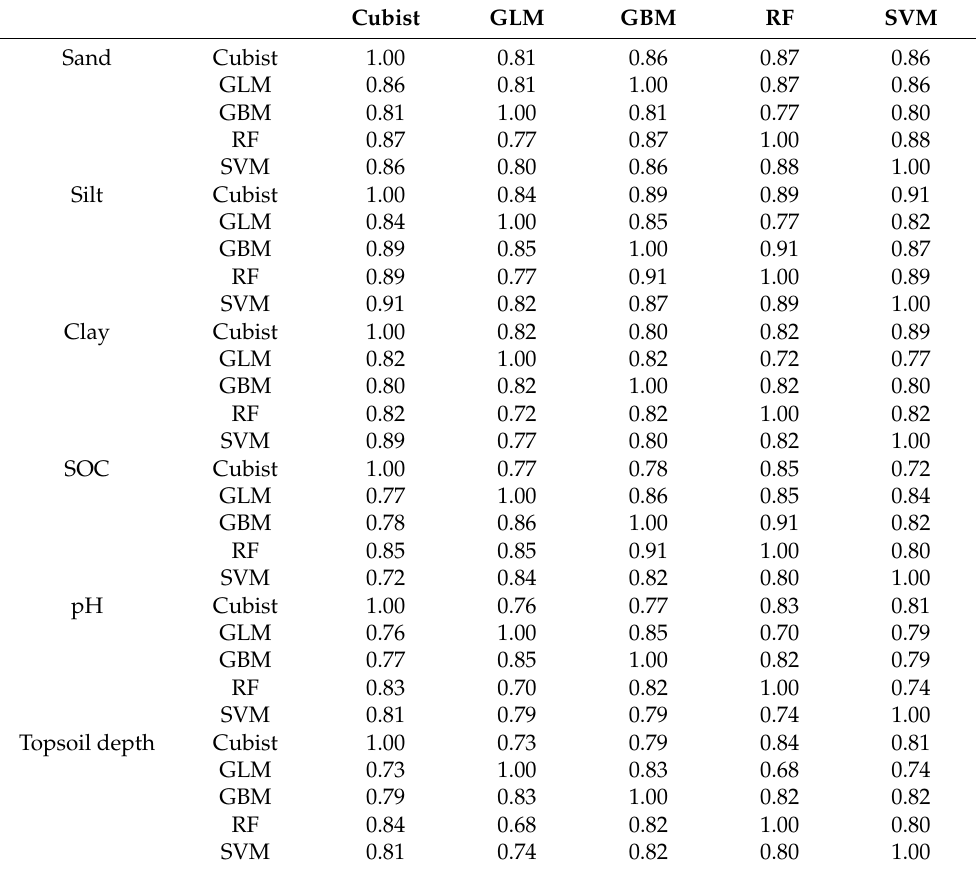
Table A1. Correlation among the predictions of the base